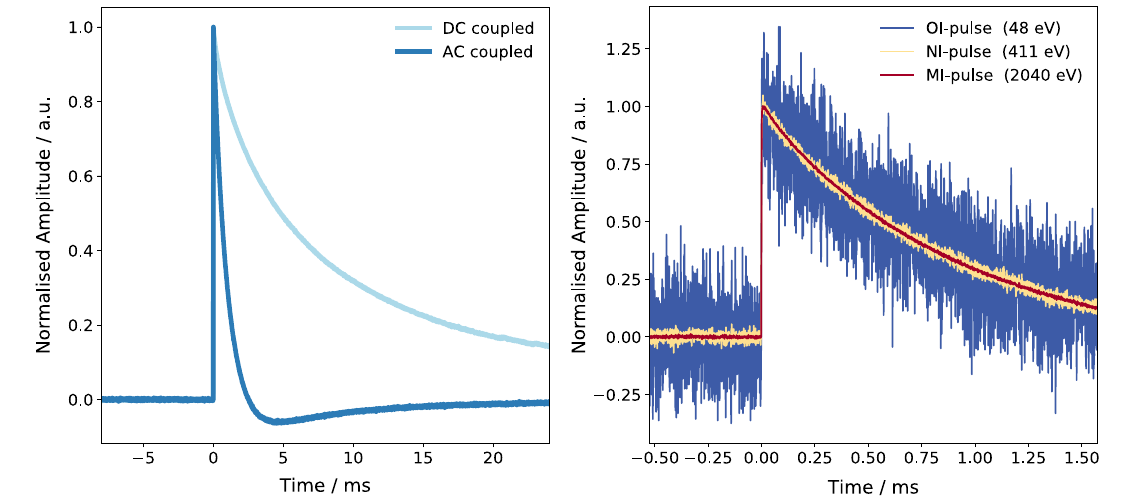
Fig. 1 Left: comparison of the pulse shape of a DC-coupled signal and an AC-coupled signal. Both traces are MI-pulses. Right: three time tracesofdifferentenergiesnormalisedtounityamplitude.MI,NIandOI